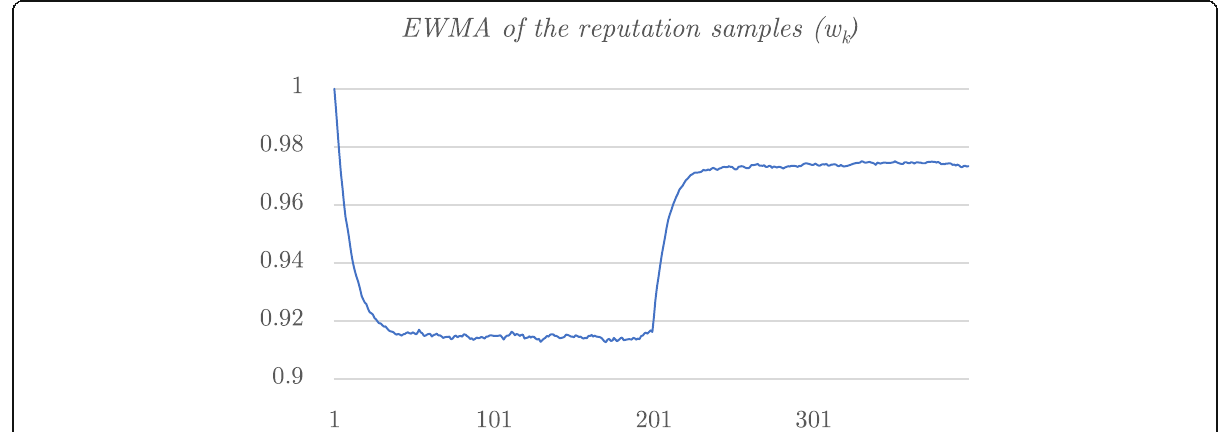
Fig. 1 Average of the reputation samples of a node if we use an EWMA when the node changes its behavior defining two stationary